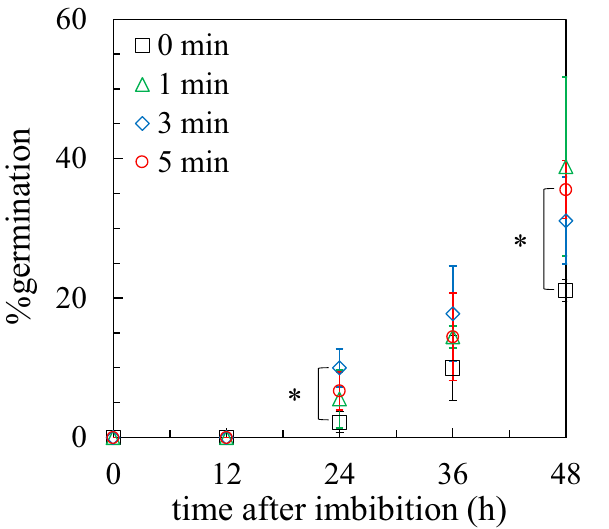
Figure 1. Germination characteristics of lettuce seeds without and with (1, 3, and 5)-min plasma